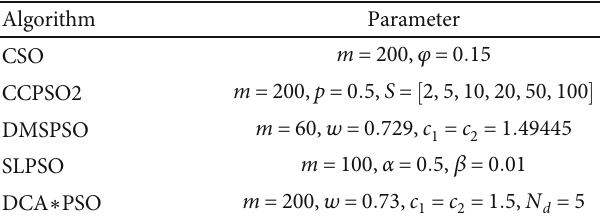
Table 4: The parameters of the algorithms.